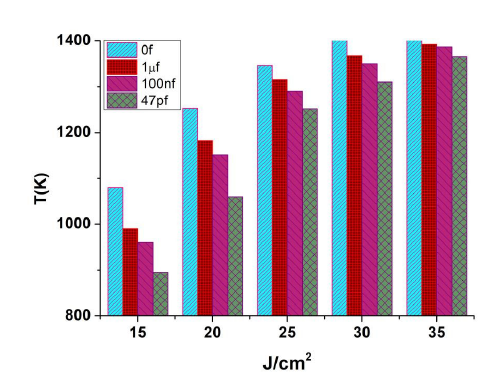
Figure 3. The maximum temperature rise on Si ‐ APD surface (pulse width 1.0 ms and different energy densities).